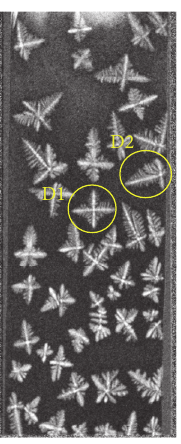
Figure 8: One selected sequential image recorded by means of synchrotron X-ray radiography [16]. The width of the image is 5.04 mm. The selected dendrites are marked by yellow